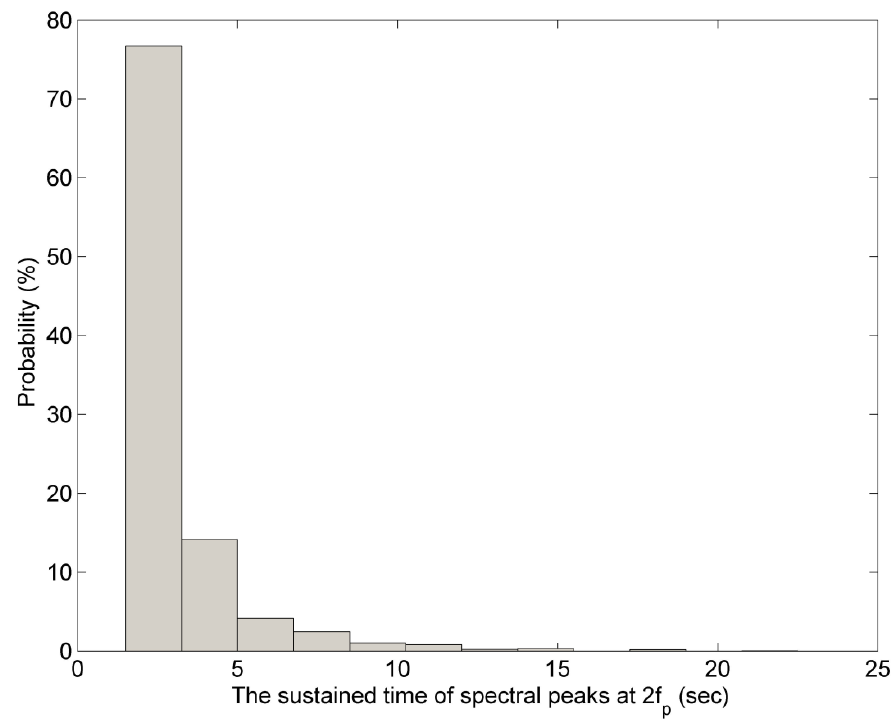
Figure 10. Probabilities of sustained time durations of the spectral peak at 2 f wavelet